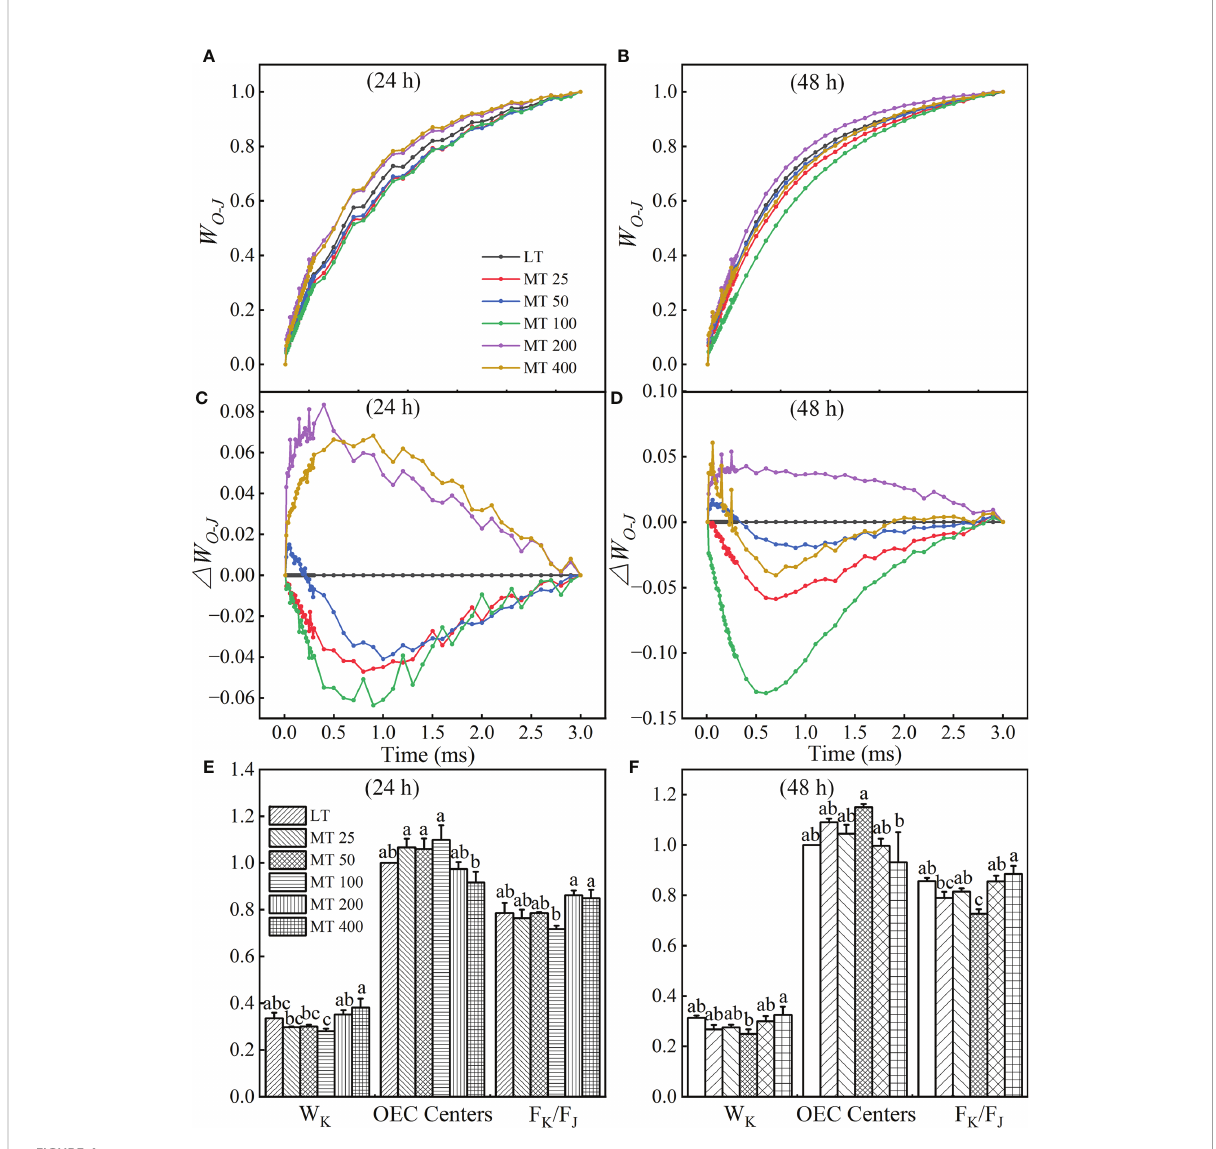
FIGURE 4 Effect of different concentrations of melatonin (MT) on the K-band of cucumber plants under low temperature stress. The OJIP curves were normalized by O and J points as W O-J = ( F t – F O )/( F J – F O ), and the difference kinetics D W O-J = W O-J (treatment) – W O-J (control) . (A, C) and (B, D) represent low temperature stress for 24 h and 48 h, respectively. Effect of different levels of MT on the values of W K , OEC centers and F k /F J at 24 h (E) and 48 h (F) of low temperature stress. The values were represented by the means ± SE. The same letters denoted that there is no signi fi cant difference at P < 0.05 according to Duncan ’ s test. Data are presented as the means of three biological